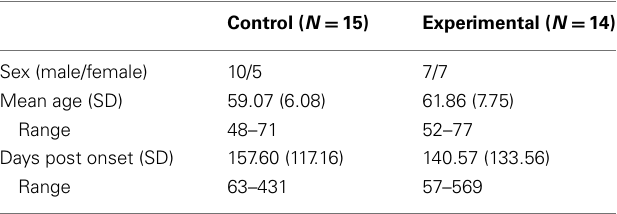
Table 1 | Medical and demographic data for both patient